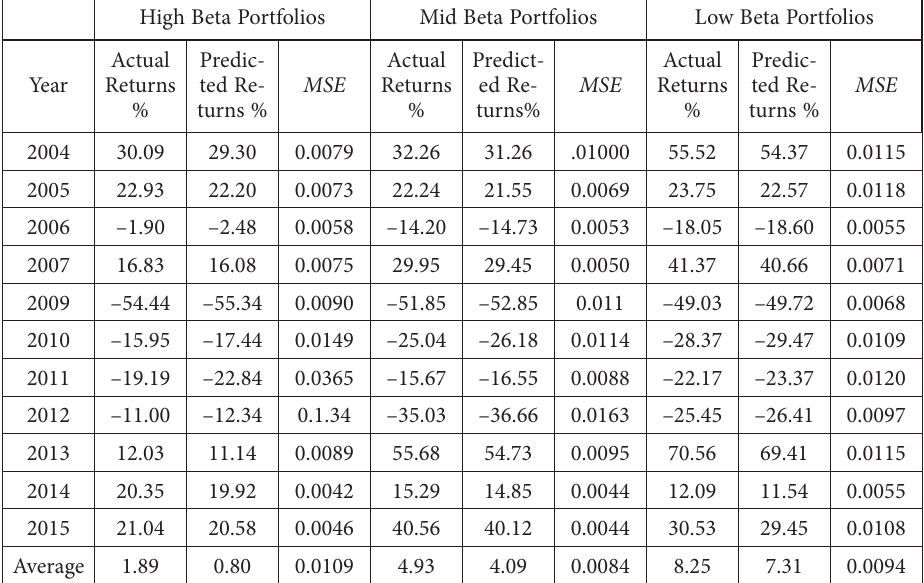
Table 3. FF5F based Actual Vs. Predicted (Annualized) Returns with